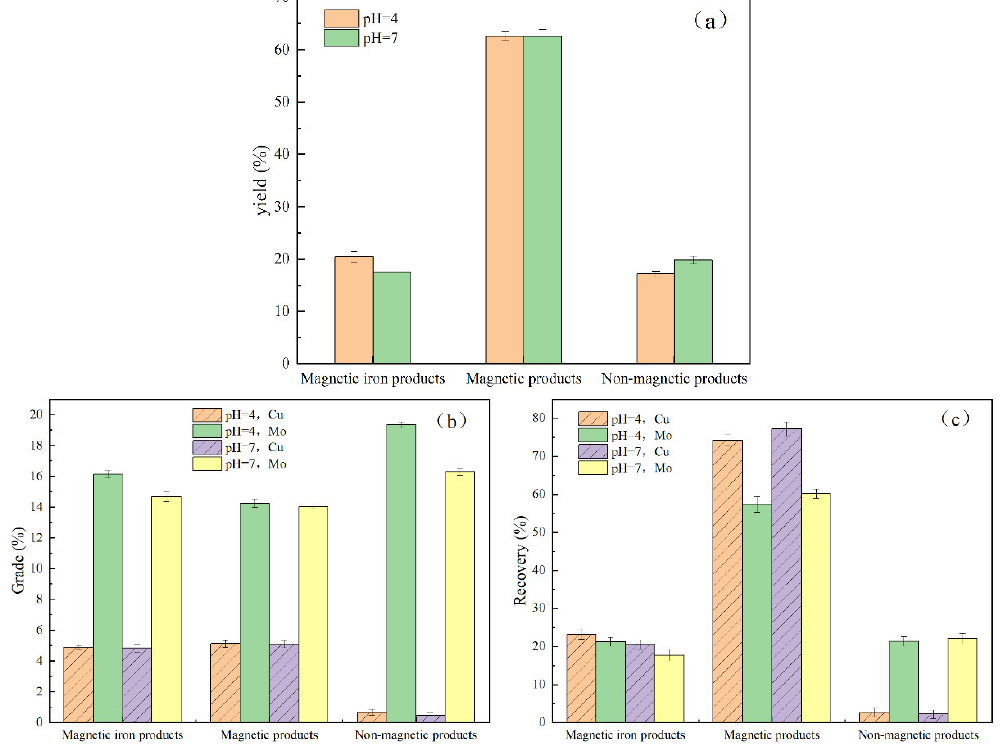
Figure 4. Separation performance of a superconducting magnetic separator at a magnetic induction of 5 T, a pulp concentration of 25%, and a feed velocity of 2 L/min. ( a ) Yield; ( b ) Grade; ( c )